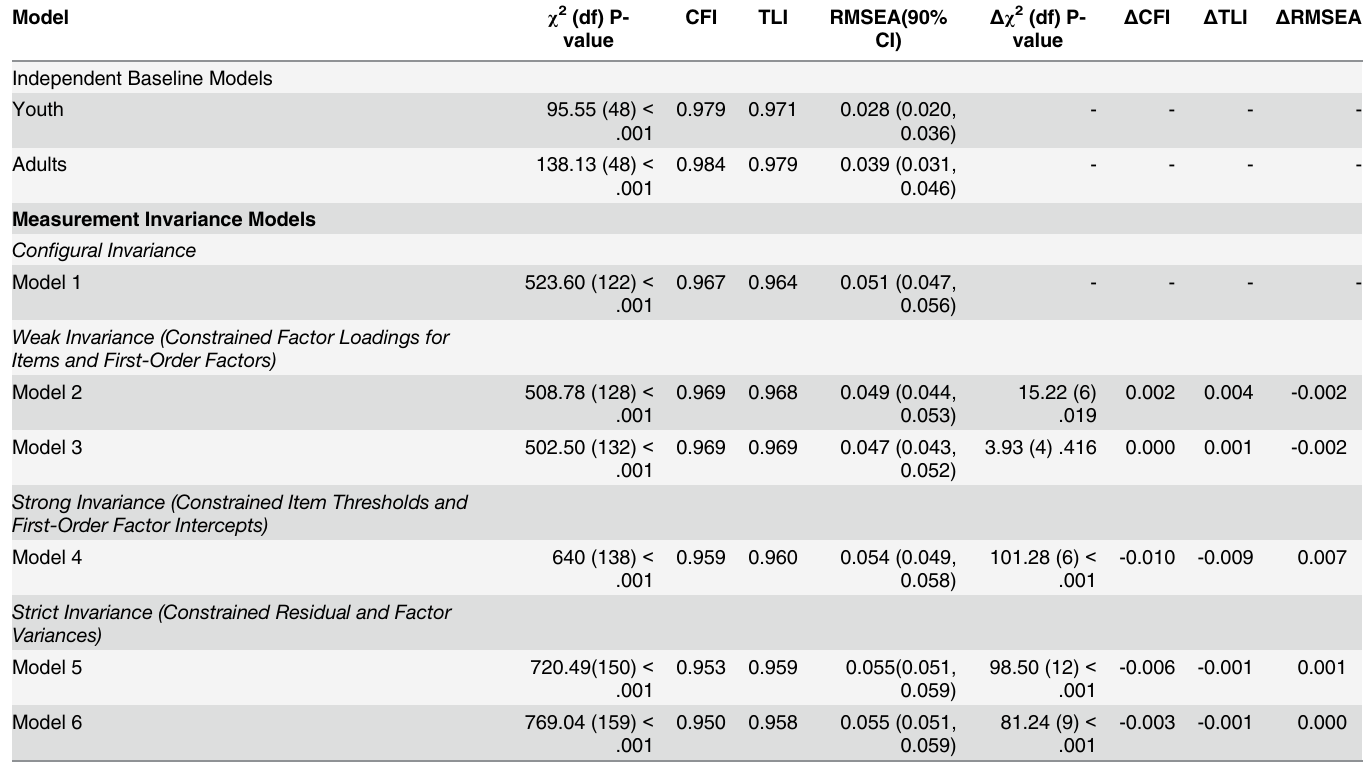
Table 4. WHODAS 2.0 Baseline Model Fit Results and Tests of Measurement